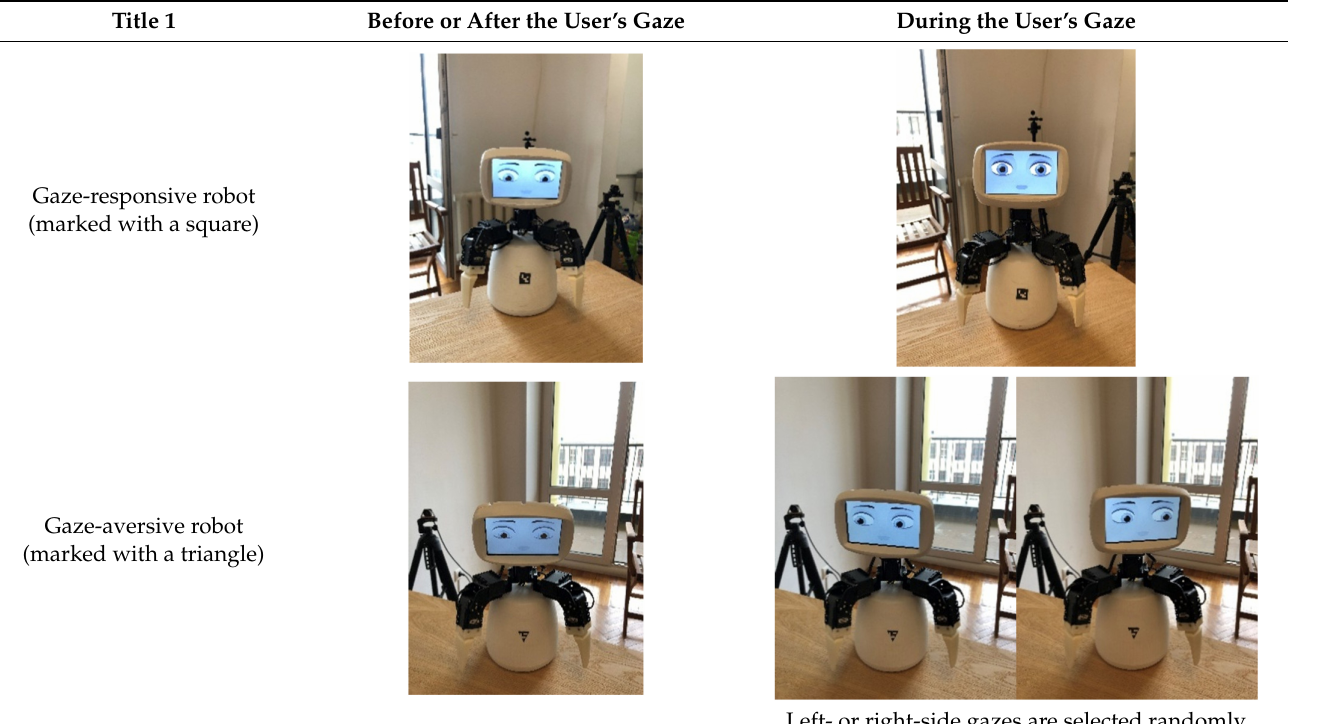
Left- or right-side gazes are selected